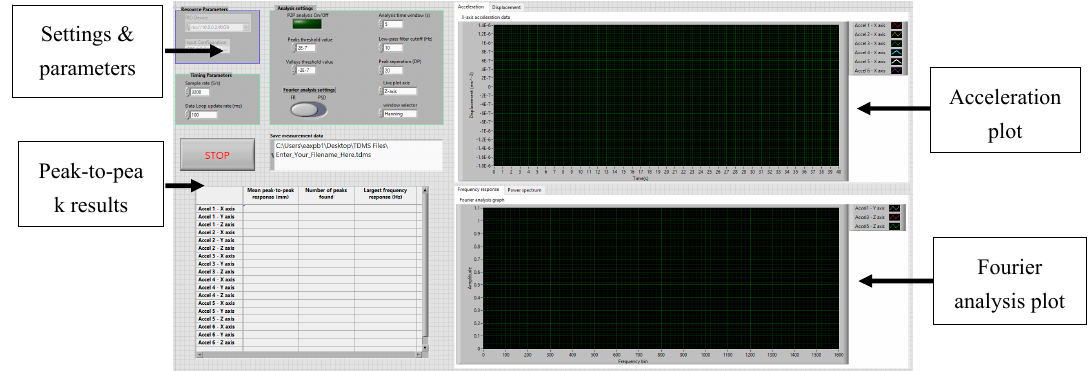
Figure 5. Front panel LabVIEW display of the multi-accelerometer host VI, which allows the user to control the system and view the measurement results.